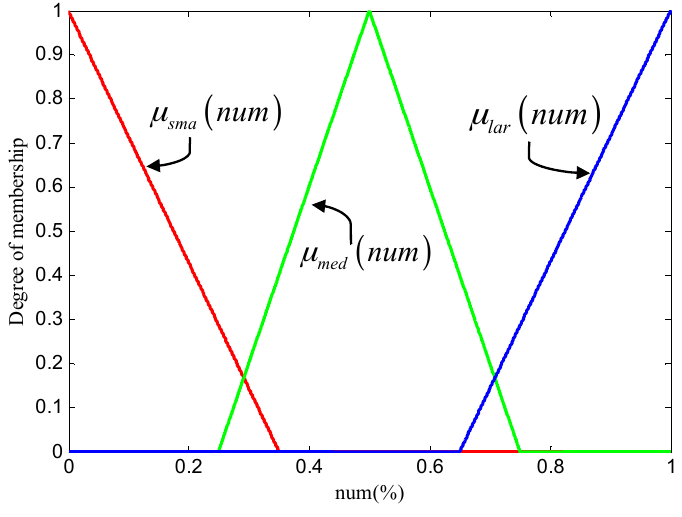
Figure 6. Membership functions of sets SMA (red line), MED (green line), LAR (blue line).